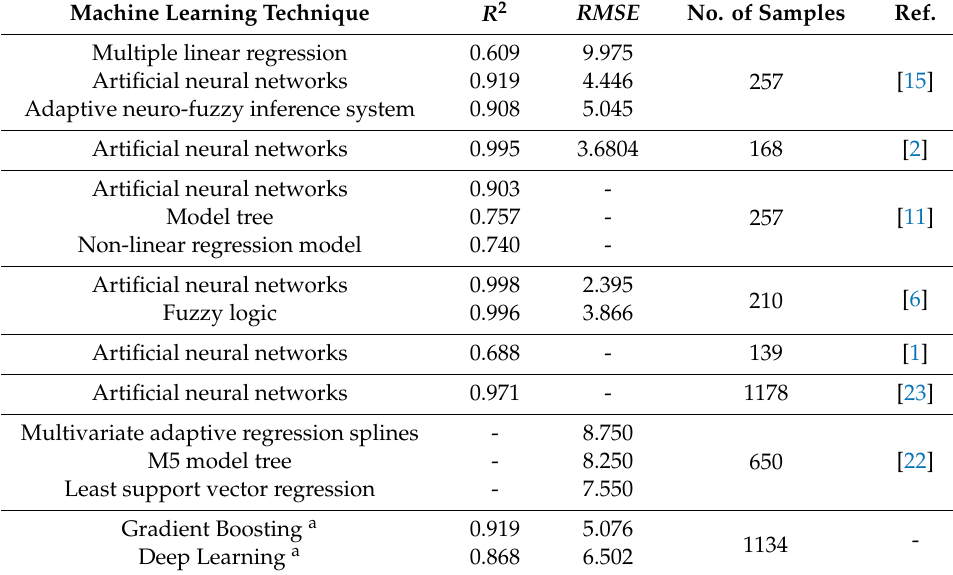
Table 14. Comparison of statistical measurements with previous